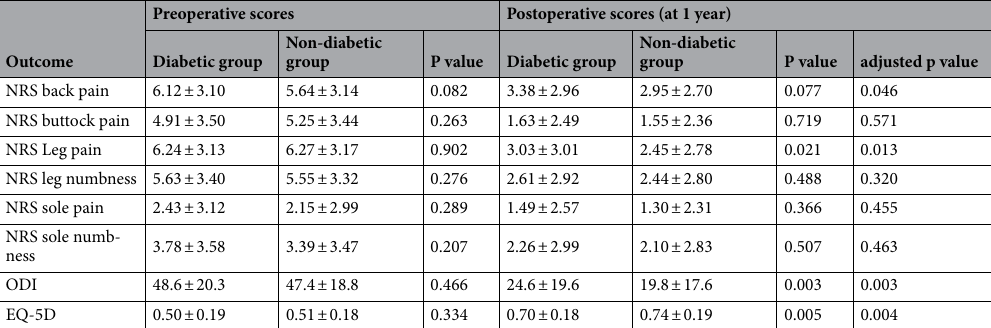
Table 2. Comparison of intra- and postoperative complications for patients with diabetes and those without diabetes.